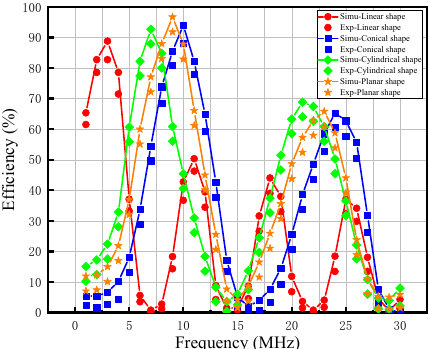
Figure 15. Comparison of simulation and experimental data of transmission efficiency among four transfer structures.